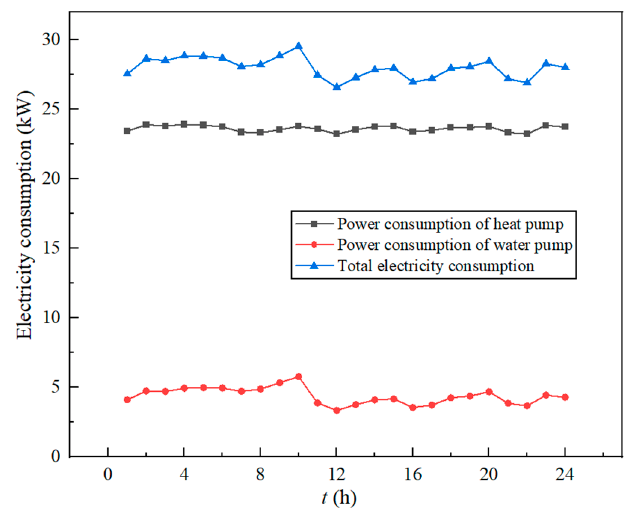
Figure 14. Electricity consumption in each period when the objective function is geothermal energy utilization coefficient.